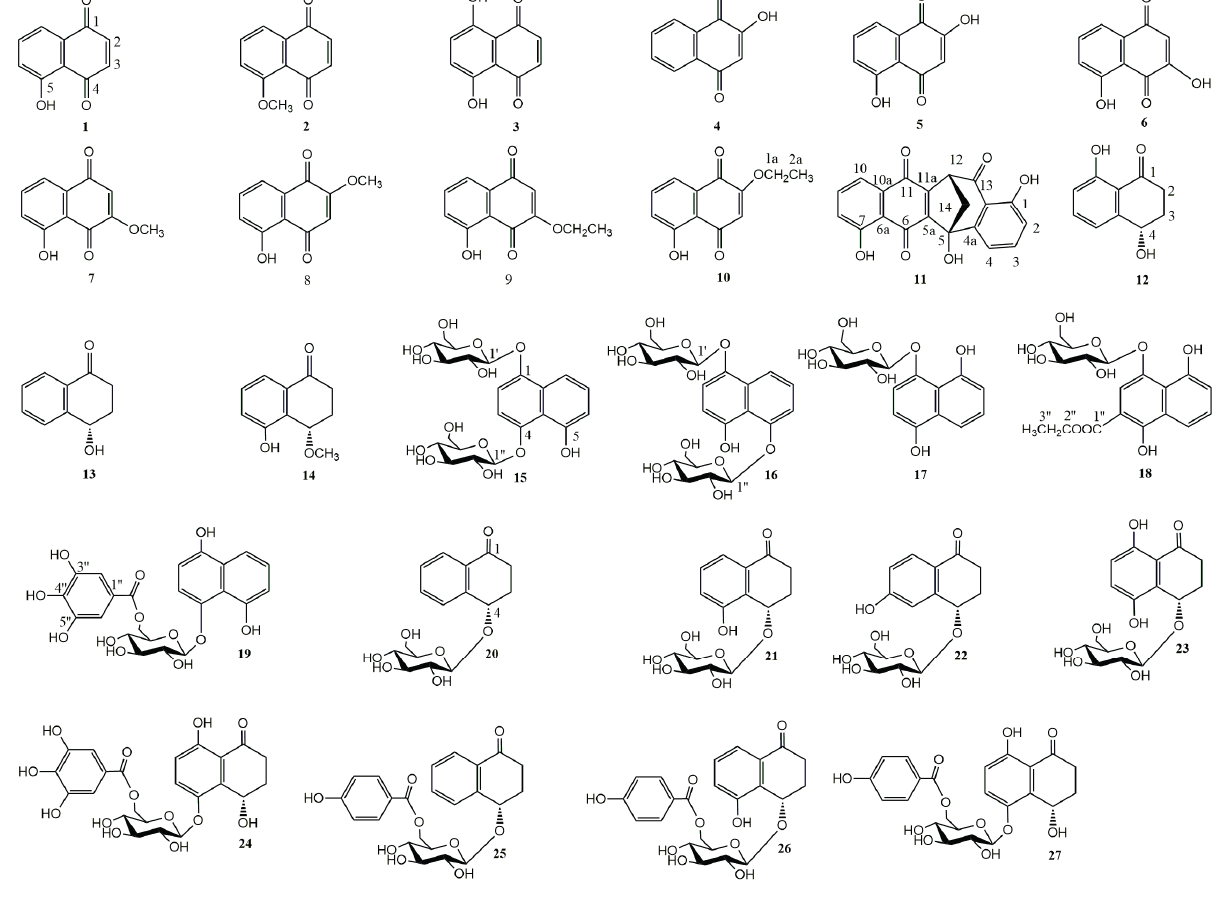
Figure 1. The chemical structures of compounds 1 – 27